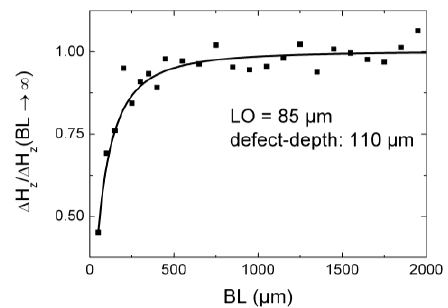
Figure 9. Normalized gradiometer signal as a function of the base line BL . The solid line depicts the simulation and the squared dots the measurement results. The EDM defect has a length of 5,500 µm, a depth of 110 µm and an opening of 90 µm. The LO was 85